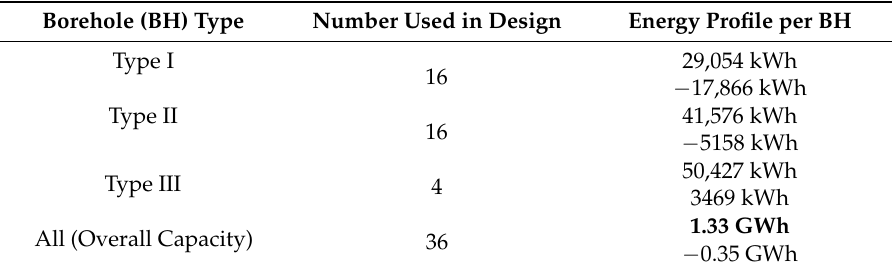
Table 4. Results for energy storage (+ sign) for 6 months and extraction ( − sign) for 6 months of all three proposed types of boreholes after thermal pre-conditioning (averaged values over 6